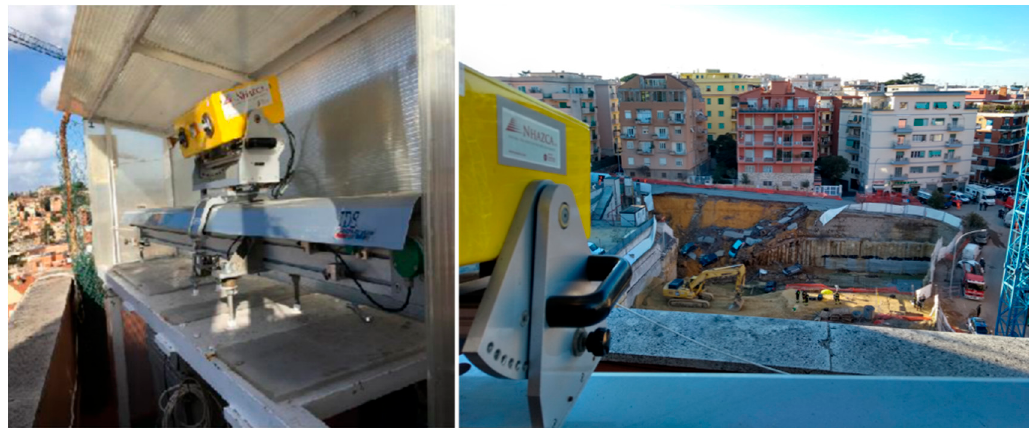
Figure 5. Terrestrial Synthetic Aperture Radar Interferometer (TInSAR) equipment deployed on the rooftop of a building located near the construction site.